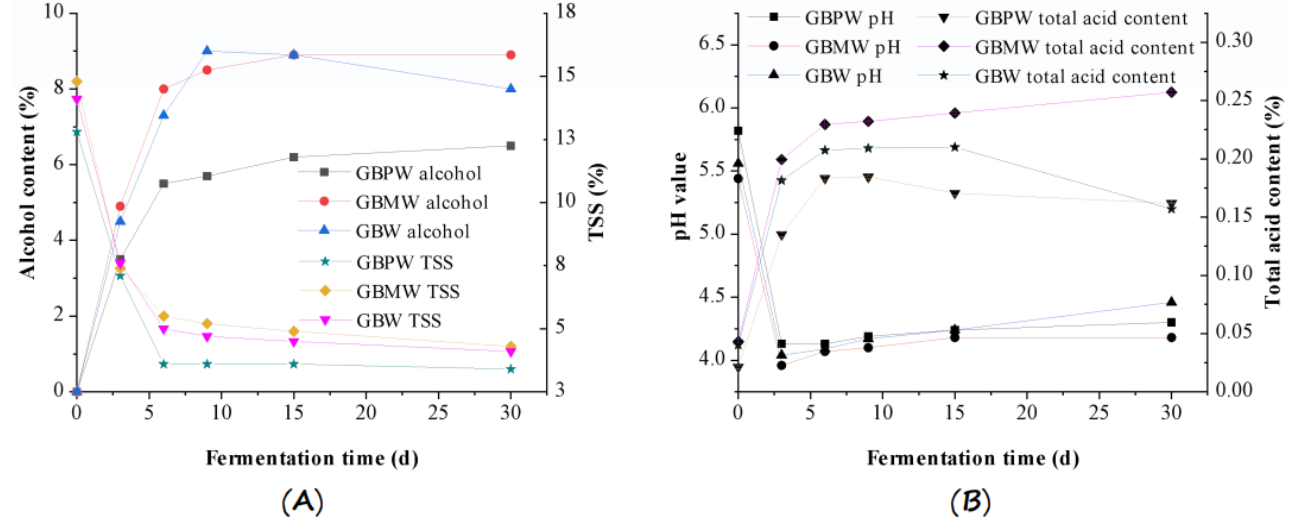
Figure 1. Changes in quality parameters of GBPW, GBMW, and GBW during fermentation of green banana samples. ( A ) Alcohol content (%) and total soluble solids (TSS %); ( B ) pH value and total acid content (%).